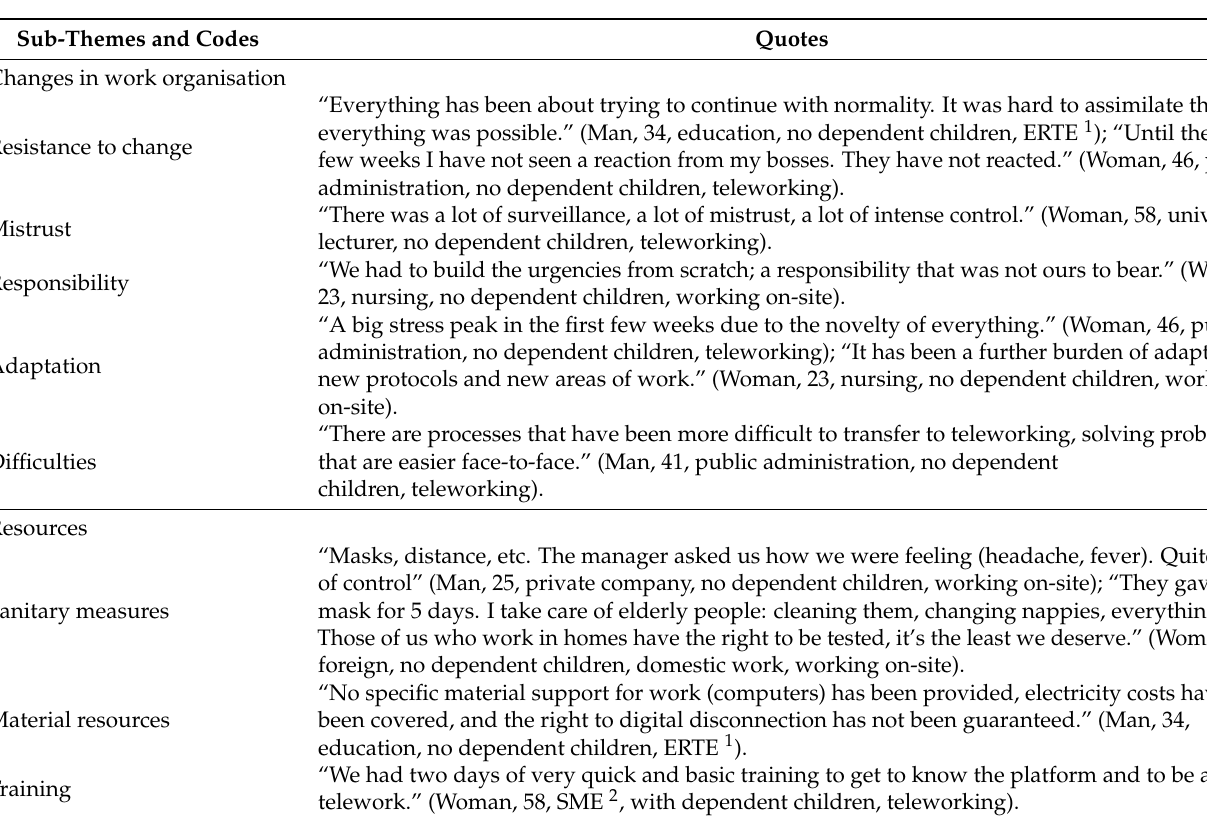
Table 2. Theme 2 developed from thematic analysis in Study 1: “consequences on work organisation and resources available for